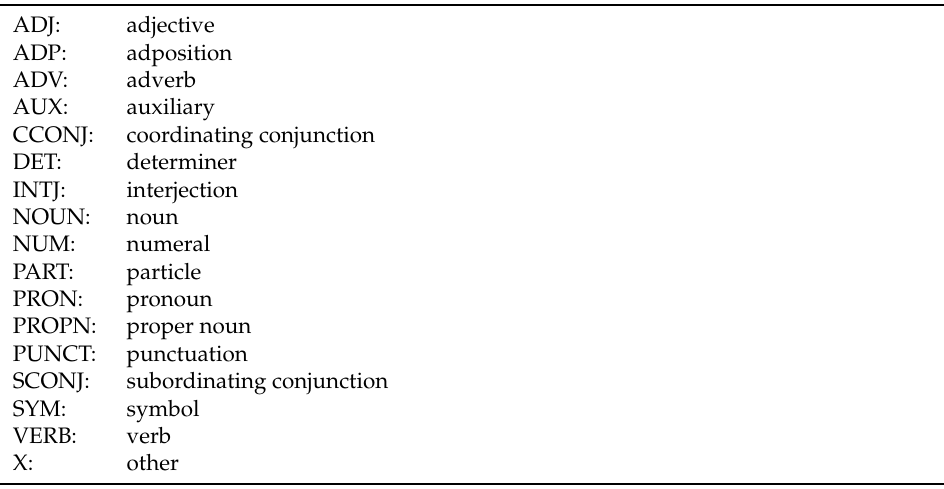
Table A2. Universal dependencies tagset (see https://universaldependencies.org/u/pos/index.html, accessed on 27 January 2023).